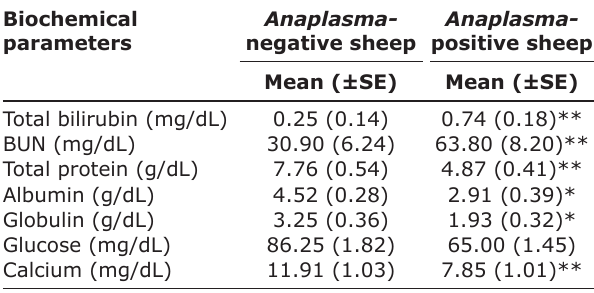
Table-3: Differences in the mean biochemical parameters between Anaplasma -negative and Anaplasma- positive sheep in North